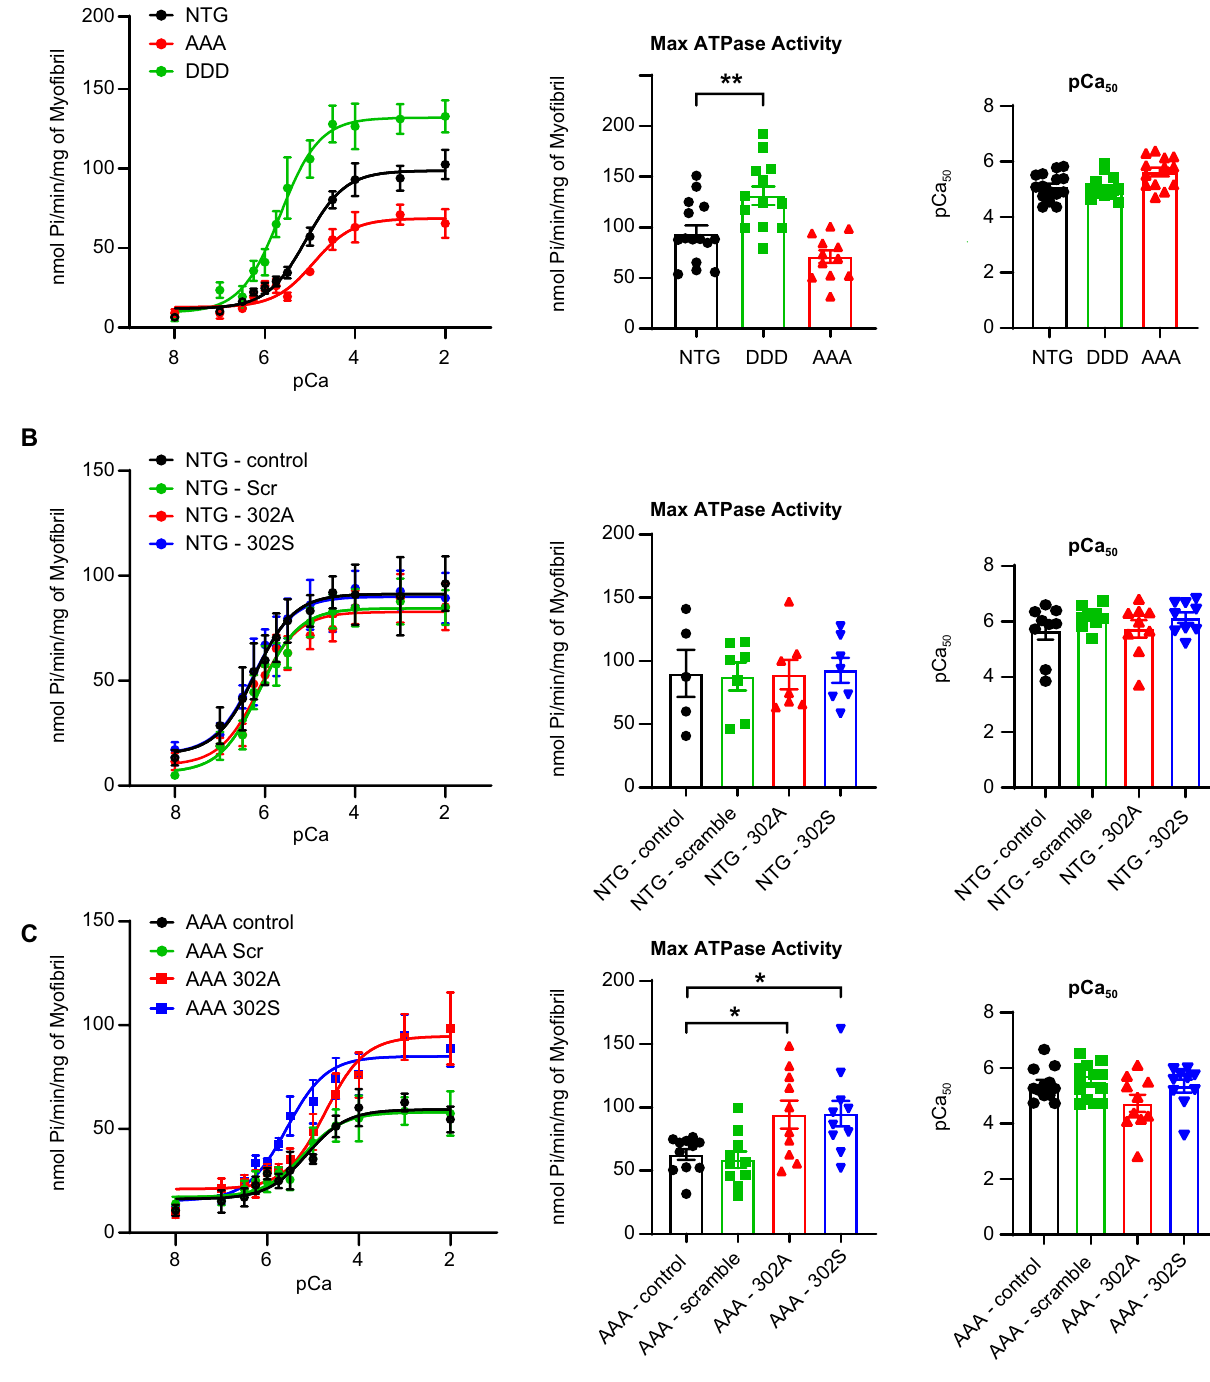
Figure 5. Effect of cMyBP-C peptides 302A and 302S in NTG and TG mice. ( A ) ATPase activity is higher in DDD TG mice compared to NTG mice. ATPase activity decreased in AAA TG mice (left). Maximal ATPase activity at pCa 2.0 was plotted in the bar graph (middle). The pCa 50 was also plotted to test calcium sensitivity (right). ( B ) Neither cMyBP-C peptide 302A nor 302S changed maximal ATPase activity in myofibrils isolated from sham mice (left and middle). No change was noted in calcium sensitivity in any of the treatment groups in sham samples (right). ( C ) cMyBP-C peptides 302A and 302S increased maximal ATPase activity in myofibrils isolated from the transgenic mice compared to nontreatment control or scrambled peptide-treated myofibrils (left and middle). No change in calcium sensitivity was noted in any of the treatment groups in TG samples (right). Data represent mean ± SEM (N = 8–15); *p < 0.05; ***p < 0.005; one-way ANOVA with Tukey post-test. TG, transgenic